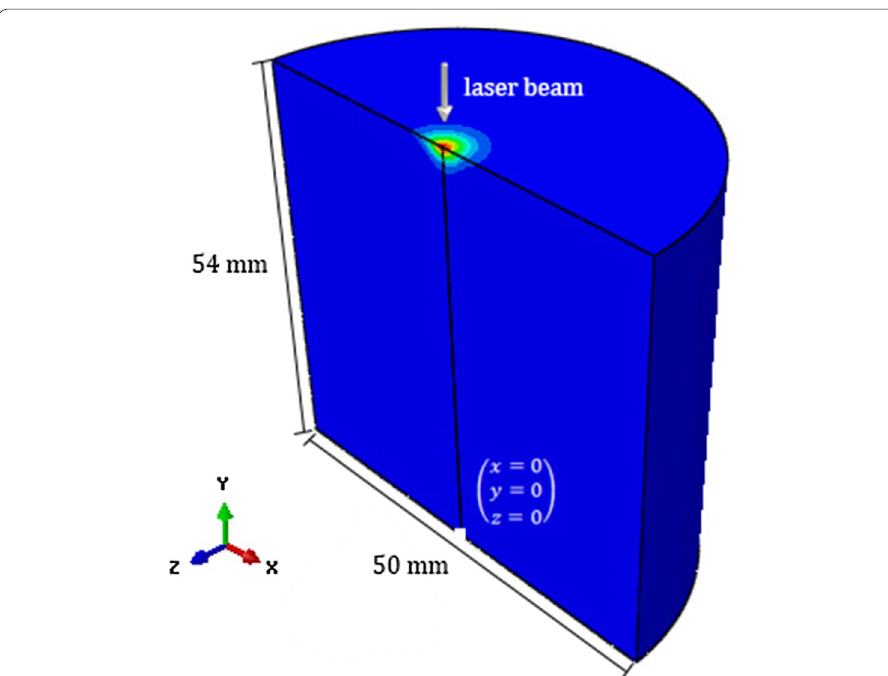
Fig. 2 A view of the geometry of model and location for applying laser beam